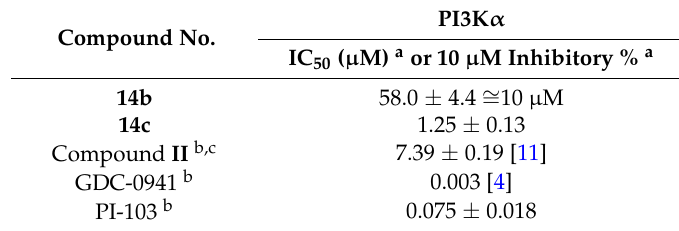
Table 2. PI3K α kinase activity of selected compounds and positive controls.